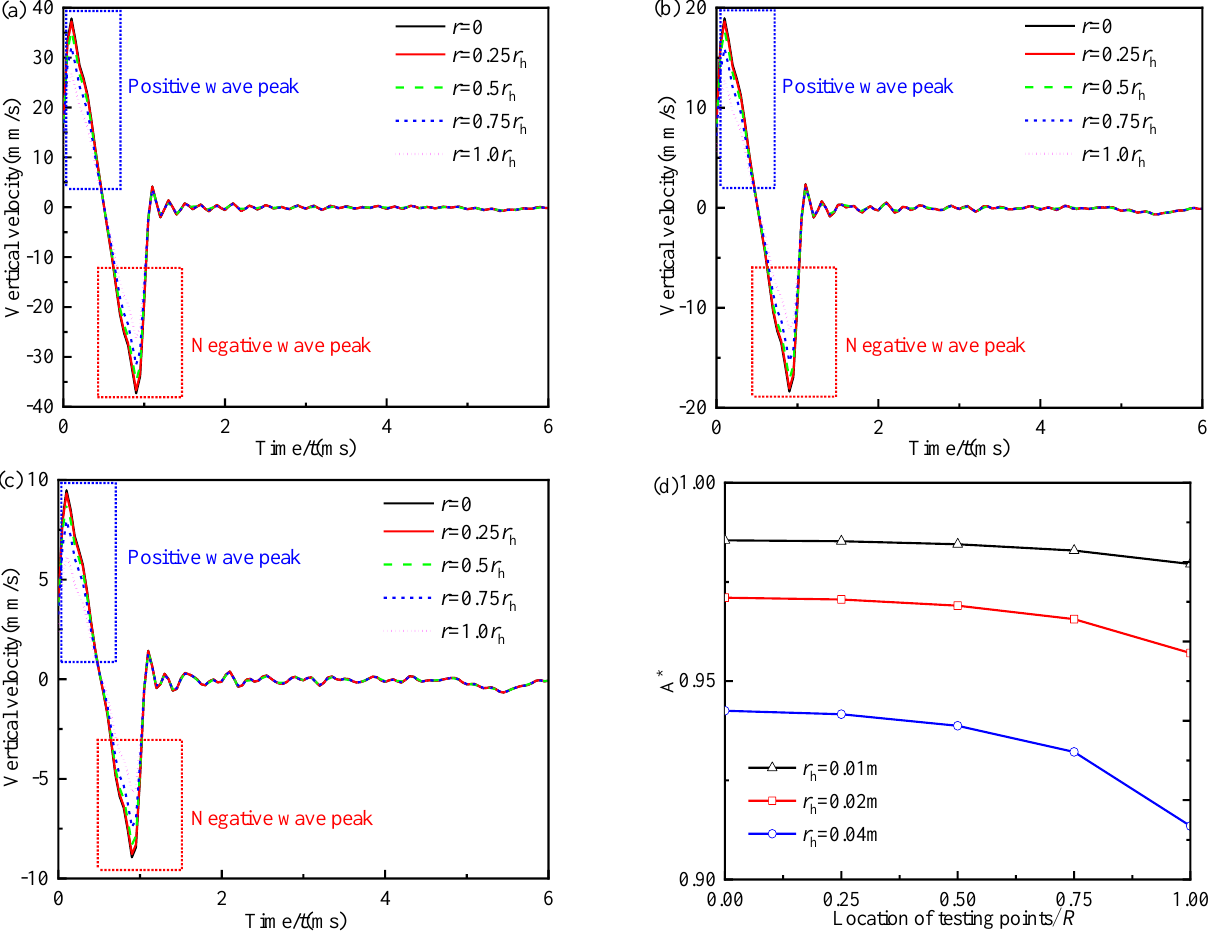
Figure 7. Velocity response in time domain of different test points along the radial direction within the excitation region for pile with R = 0.75 m: ( a ) r h = 0.01 m; ( b ) r h = 0.02 m; ( c ) r h = 0.04 m; ( d ) Variation of the negative-positive-ratio.